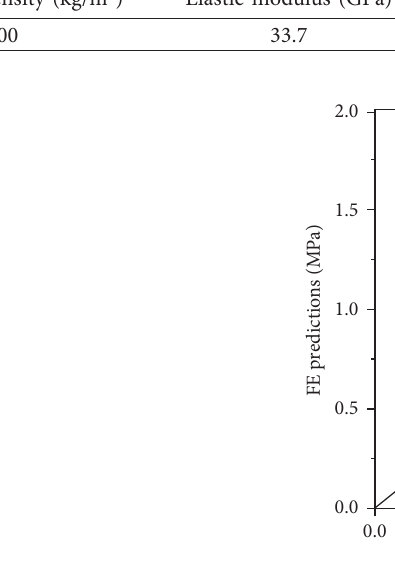
Figure 13: Comparisons between test and simulation